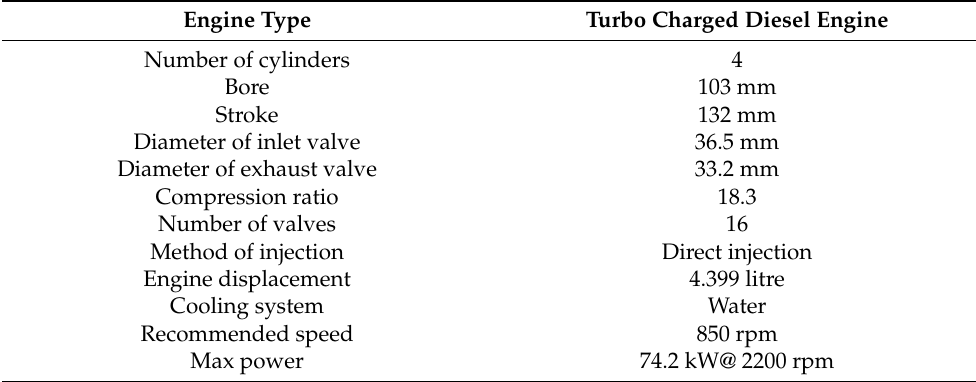
Table 1. Characteristics of the test engine.